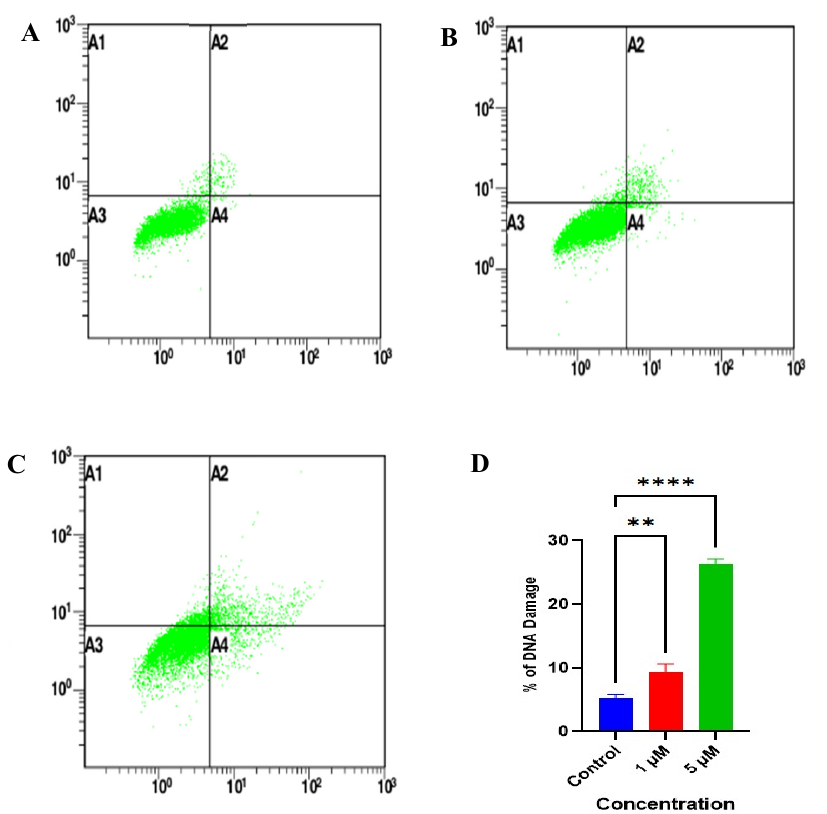
Figure 6. DNA damage-inducing effect of complex 2. In ( A – C ), A1: percentage of ATM-activated cells, A2: percentage of DNA double-strand breaks (dual activation of both ATM and H2A.X), A3: percentage of negative cells (e.g., no DNA damage), ( D ) the total DNA damage (A1 + A2 + A4). A significant increase in DNA strand breaks was observed in complex 2 treated cells in a dose-dependent manner. The (**) and (****) is significant compare to control.